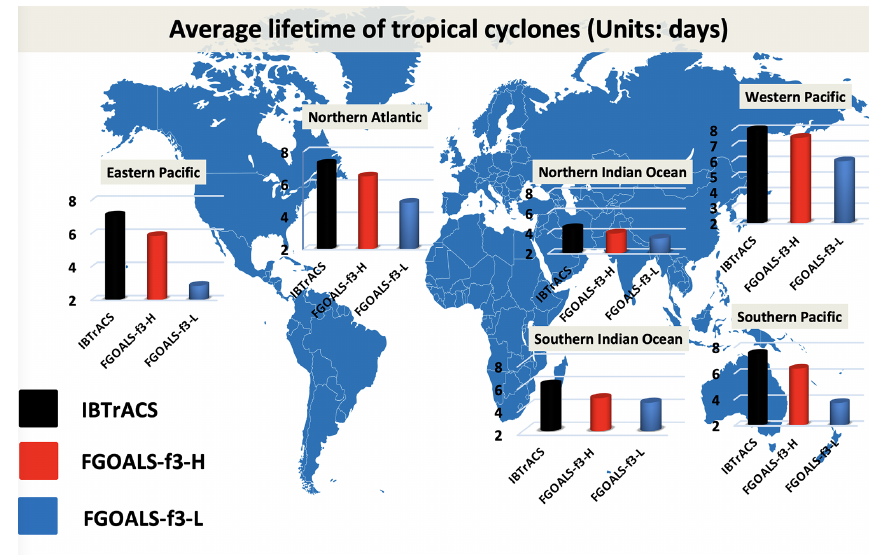
Figure 5. Climatological lifetime of tropical cyclones in the western Pacific, southern Pacific, northern Indian, northern Atlantic, eastern Pacific oceans and southern Indian oceans (units: d) during the time period